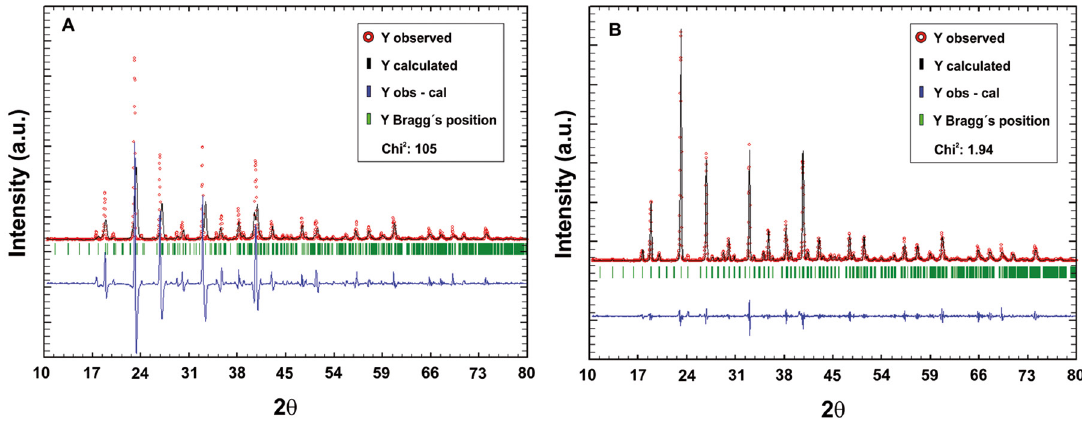
Figure 6: First (A) and last (B) stage of refining diffraction patterns, where the evolutionary process of the method used is observed.